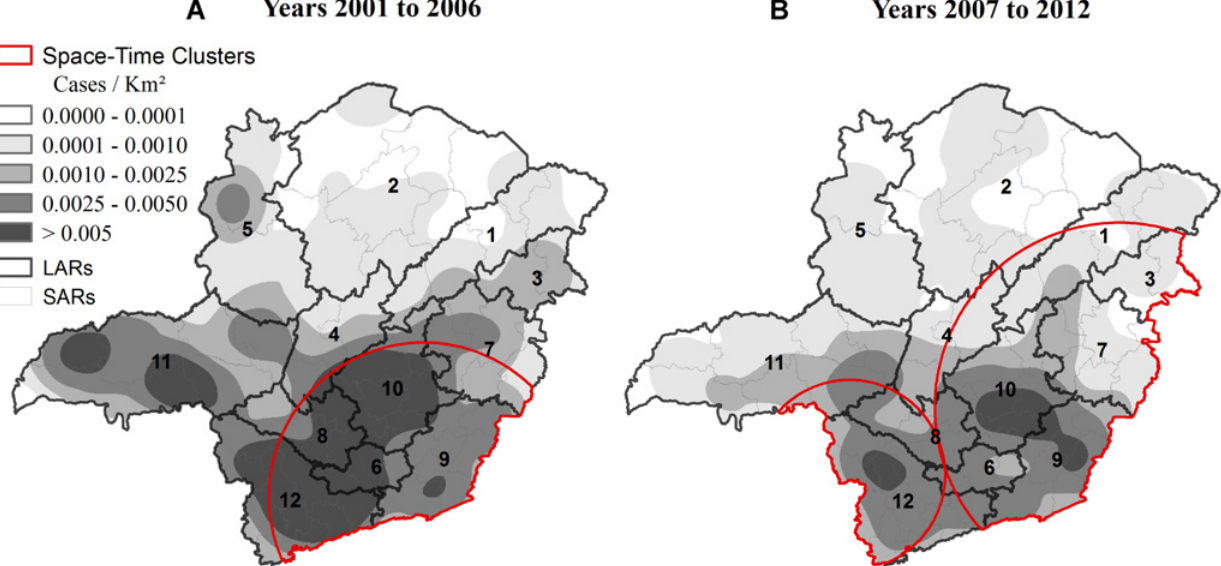
Fig 5. Kernel density map and spatial-temporal clusters of positive diagnoses for herbivore rabies in Minas Gerais, Brazil, from 2001 to 2012.